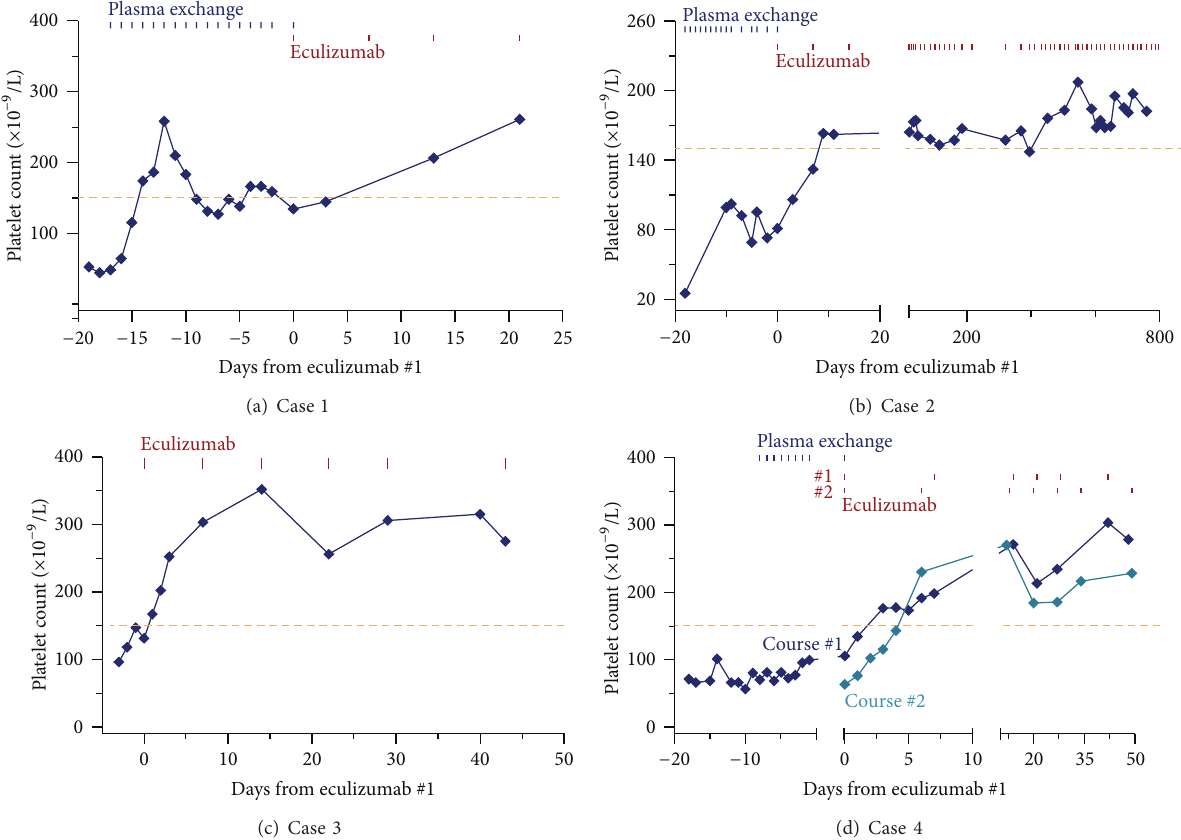
Figure 1: Rapid resolution of thrombocytopenia with eculizumab therapy for aHUS. In Cases 1–4 of aHUS (panels a–d), the platelet counts began to steadily increase within 3 days, normalizing by day 7 following initiation of eculizumab therapy. Such rapid and steady increase in the platelet count did not occur in three cases when they were treated with plasma exchange. The dashed lines mark the lower limit of normal platelet